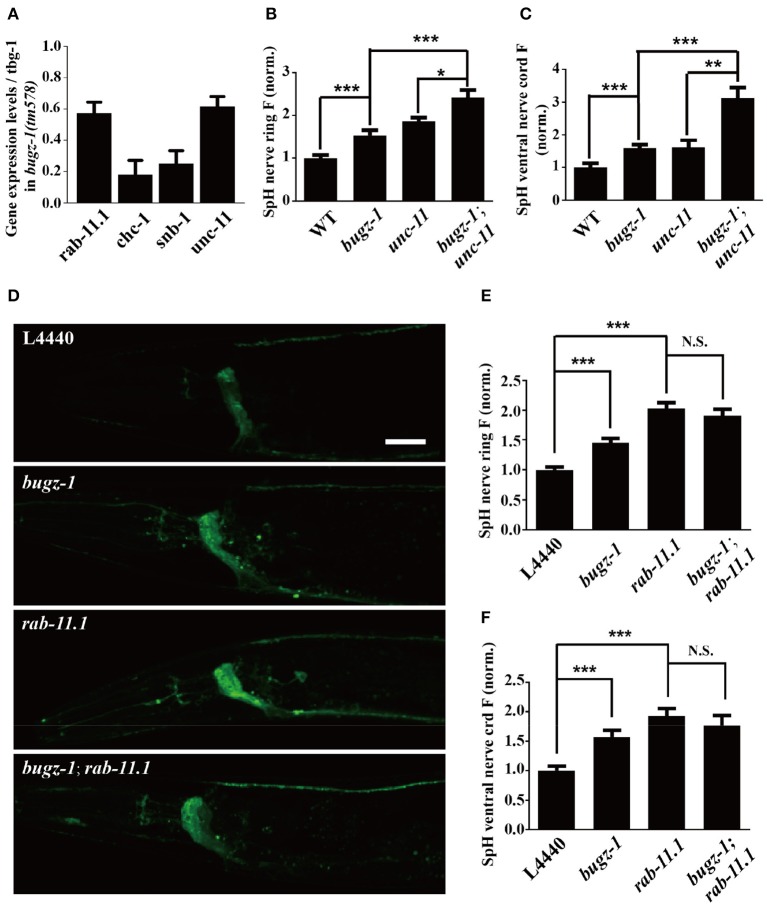
rab-11.1 is a likely direct target of BuGZ-1. (A) qRT-PCR verification of down-regulation of rab-11.1, chc-1, snb-1, and unc-11 transcript levels in bugz-1(tm578) mutant relative to wild type. (B,C) Quantification of SpH fluorescence in the nerve ring (B) and ventral nerve cord (C) of N2, bugz-1, unc-11, and bugz-1;unc-11 worms. n ≥ 14. (D) Representative confocal images of eri-1(mg366);lin-15b(n744);Is[snb-1::pHluorin] worm treated with L4440, bugz-1, rab-11.1, and bugz-1;rab-11.1 RNAi bacteria. Scale bar indicates 10 μm. (E,F) Quantification of fluorescence in the nerve ring (E) and ventral nerve cord (F) of indicated RNAi treatment which normalized to the L4440 control. n ≥ 14. Values that significantly differ from controls are indicated (*p < 0.05; **p < 0.01; ***p < 0.001 by two-tails Student's t-test). N.S. indicates no significant difference between genotypes compared. Error bars represent SEM.